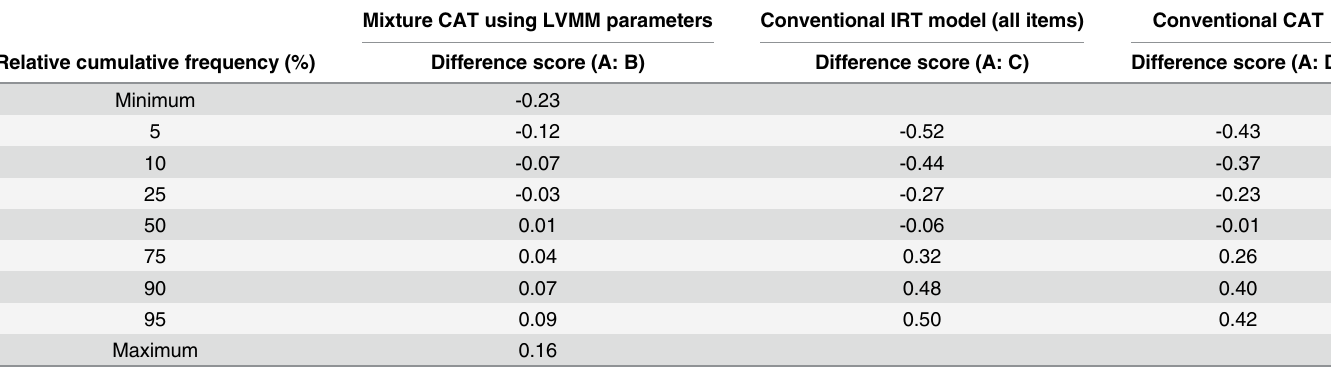
Table 3. Cumulative Frequency Distributions of Difference Scores of